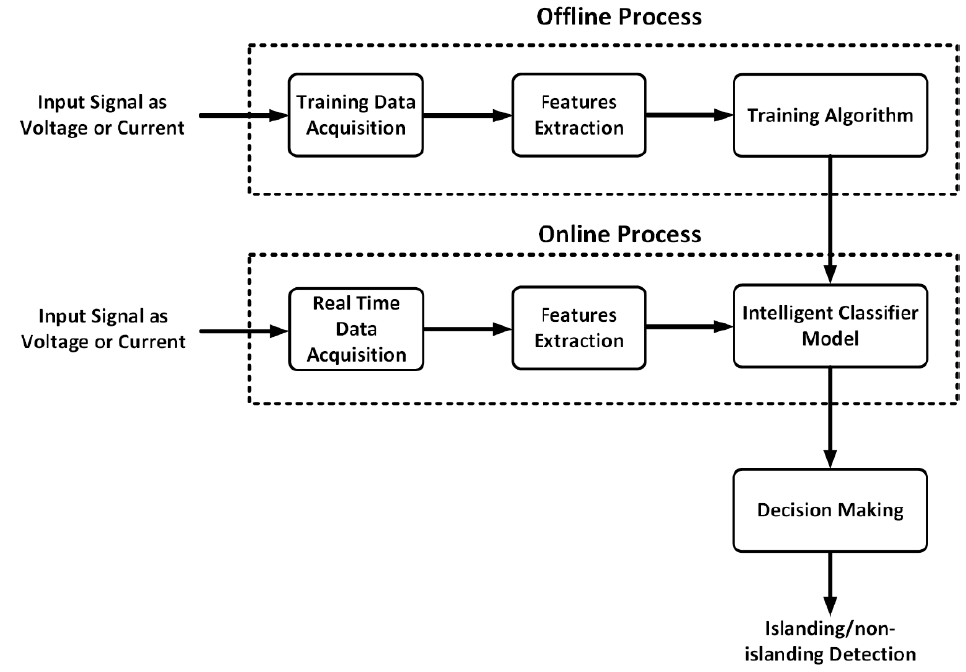
Figure 3. Schematic of intelligent IdMs.